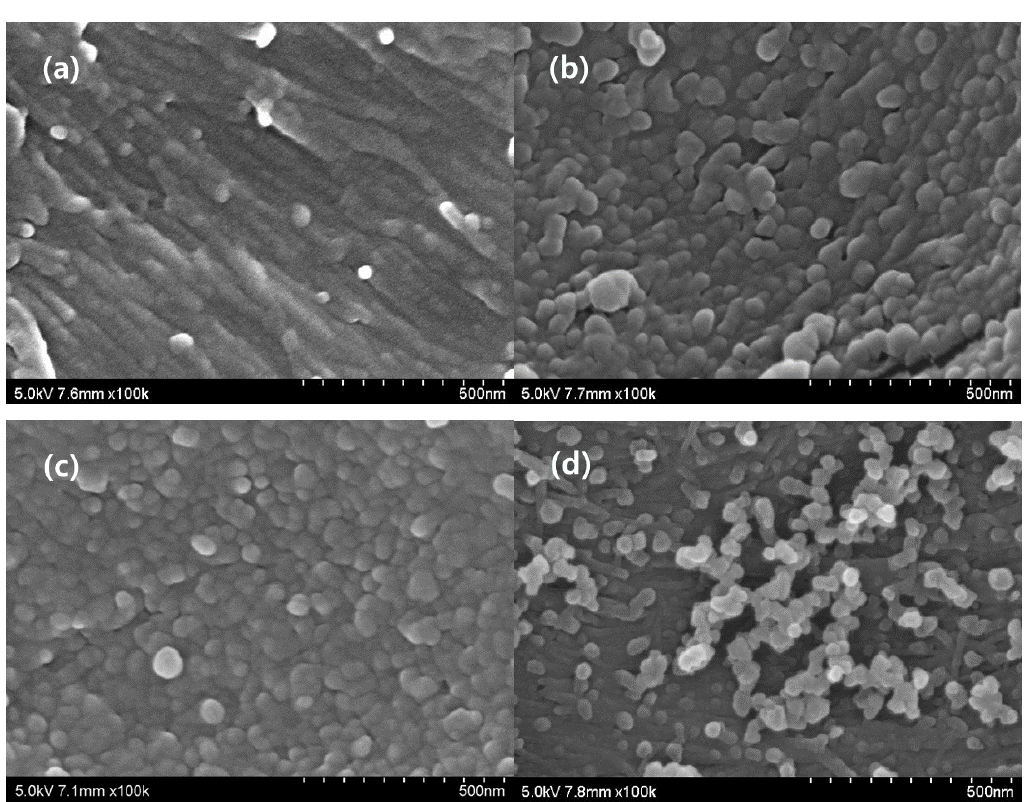
Figure 3. SEM images of the ALEW pretreated Eucalyptus samples, according to the different drying methods, namely: the ( a ) untreated control, ( b ) air drying (AD), ( c ) freeze drying (FD), and ( d ) critical point drying